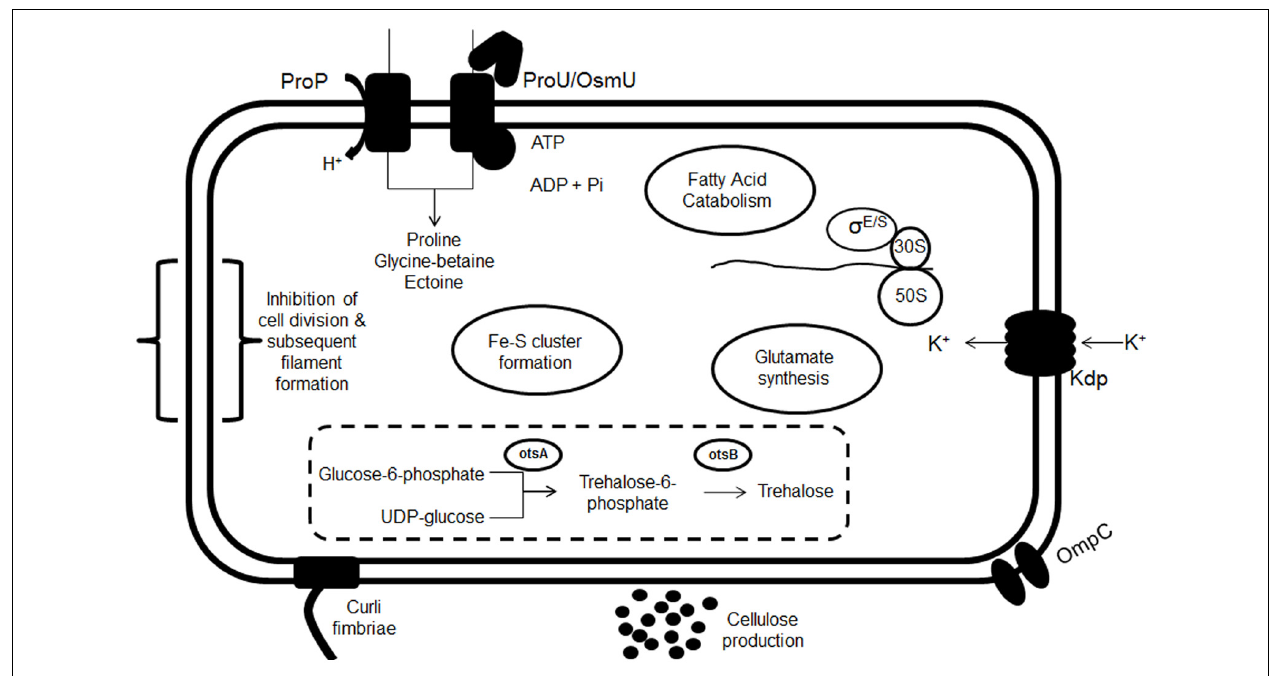
formation and filament formation have also been observed, as well as an up-regulation of the RpoE and RpoS regulators. An increase in the number of OmpC porins in reduced moisture has also been observed. Finally there may be a possible role for cellulose and curli fimbriae in